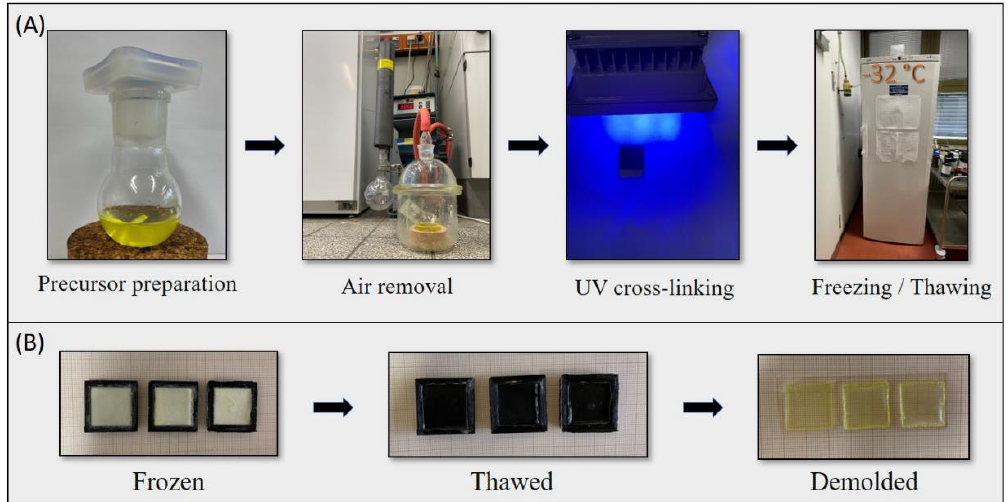
Figure 8. ( A ) Preparation processes of photo-crosslinked PVA/(PVA-MA)-g-PNIPAM hydrogels. ( B ) Photos of PVA/(PVA-MA)-g-PNIPAM hydrogel in processes. ( B ) Photos of PVA/(PVA-MA)-g-PNIPAM hydrogel in